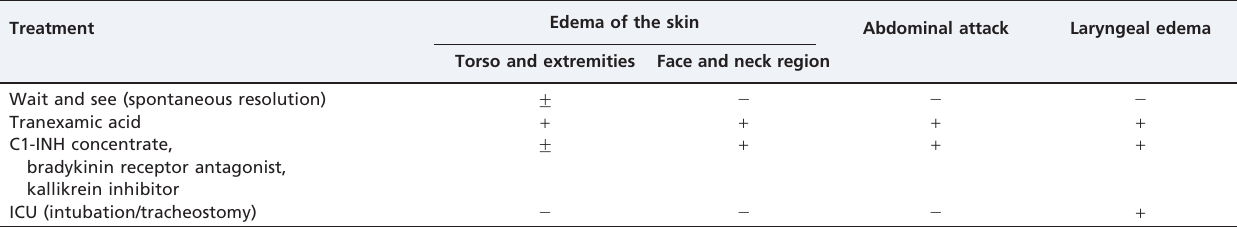
Table 7 - Parameters for the treatment of acute attacks in patients with hereditary angioedema. 6,38